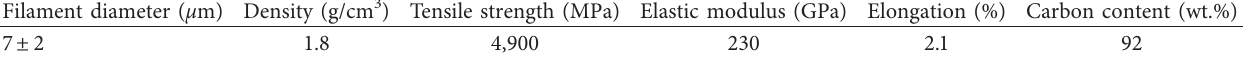
Table 2: Physical properties of the carbon fiber.